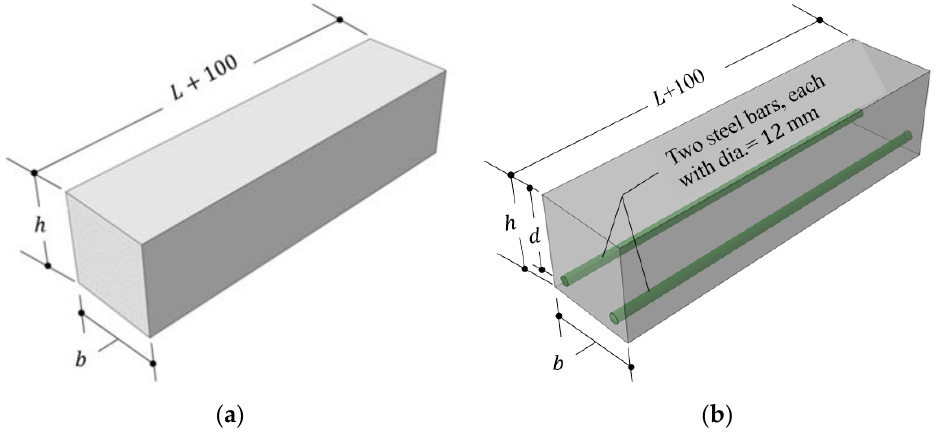
Figure 5. ( a ) Set A and ( b ) set B-F (dimensions are in mm).